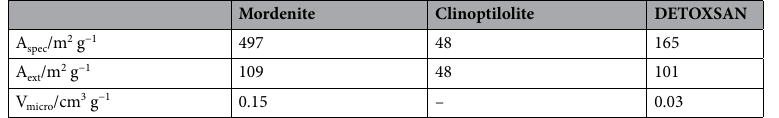
Table 2. Textural properties of mordenite, clinoptilolite and DETOXSAN containing both zeolites shown textural properties are the specific surface area (A spec ), external surface area (A ext ), and micropore volume (V micro